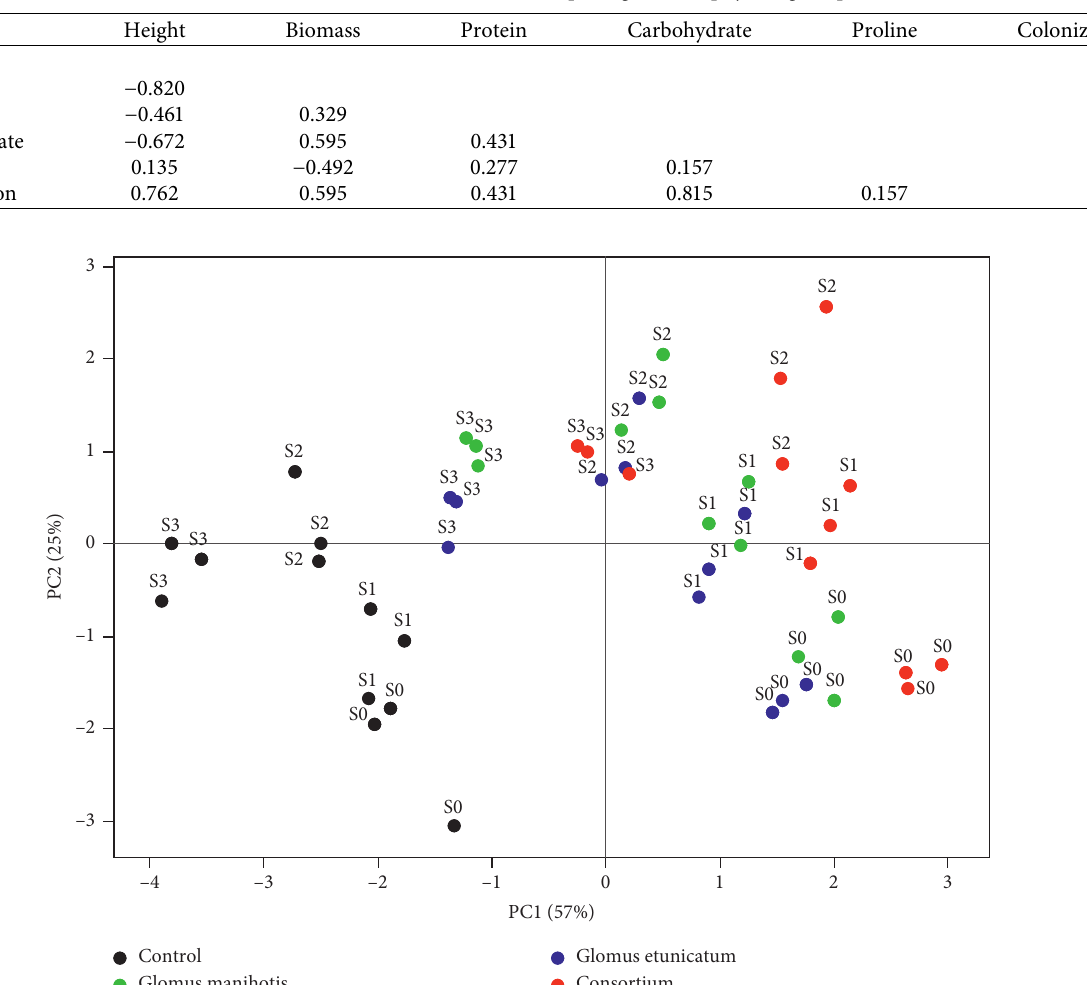
Figure 10: PCA plots of the two principal components of L. leucocephala, S0: control/0mM NaCl, S1: 150mM NaCl, S2: 300mM NaCl, S3: 450mM NaCl; PC1: principal component 1, PC2: principal component